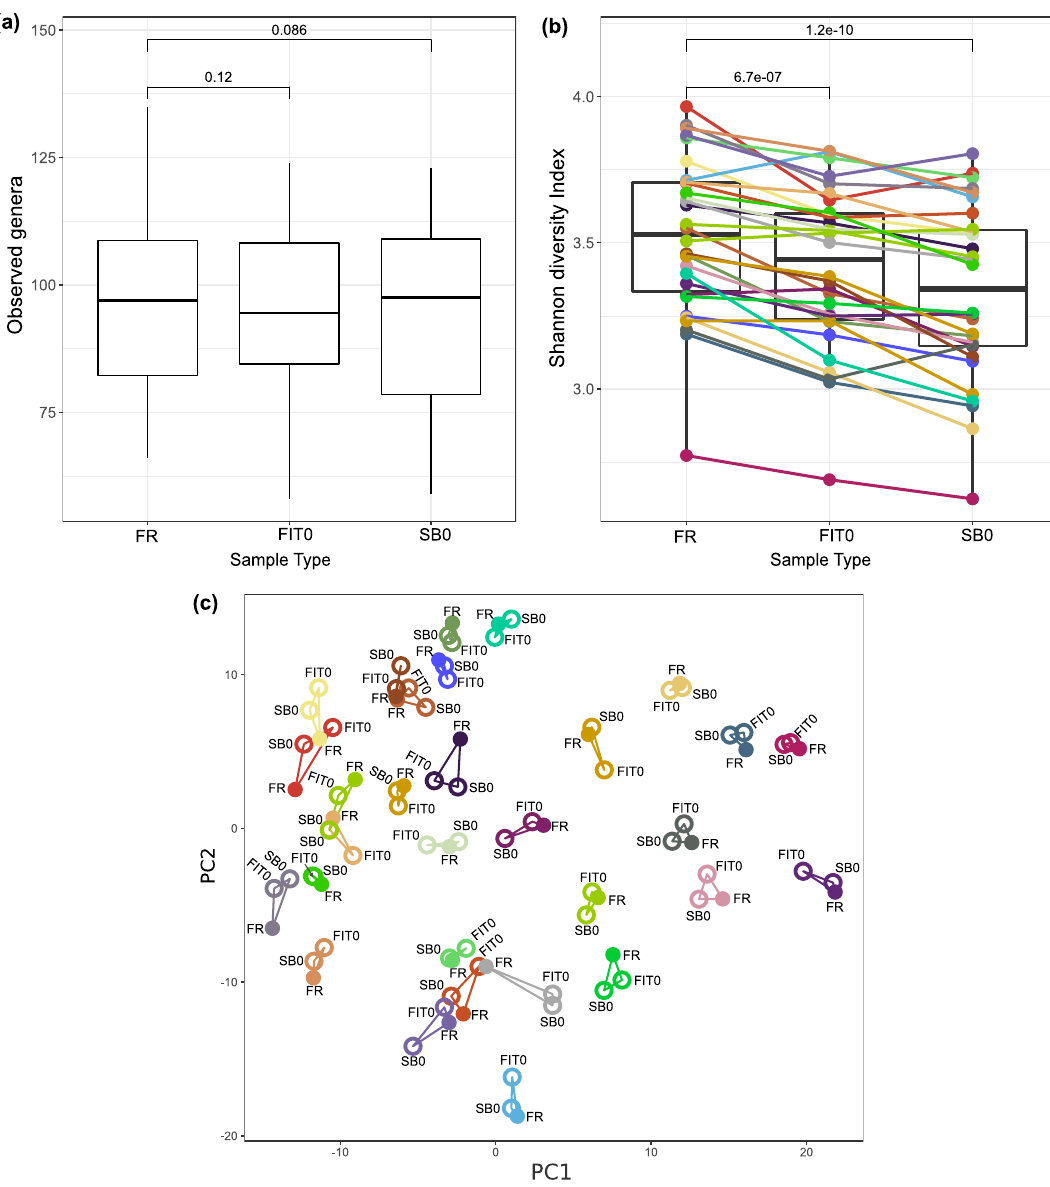
Figure 3. Comparison of microbiome diversity between different sample types. Boxplots represent two different alpha diversity measurements: ( a ) richness or number of taxa observed and ( b ) Shannon diversity index. Median values and interquartile ranges are indicated in the plots. In the richness analysis, paired t tests indicated that the differences were not significant (FDR FR-FIT0 = 0.12, FDR FR-SB0 = 0.086). In the Shannon diversity index plot, samples from the same patient are connected and colored to illustrate the lower trend of alpha diversity for FIT0 and SB0 relative to FR (FDR < 0.01). ( c ) Principal component analysis (PCA) of beta diversity between storage conditions. Samples are colored and linked based on the individual’s ID. FR fresh-frozen samples; FIT0 immediately frozen FIT samples; SB0 immediately frozen stabilization buffer